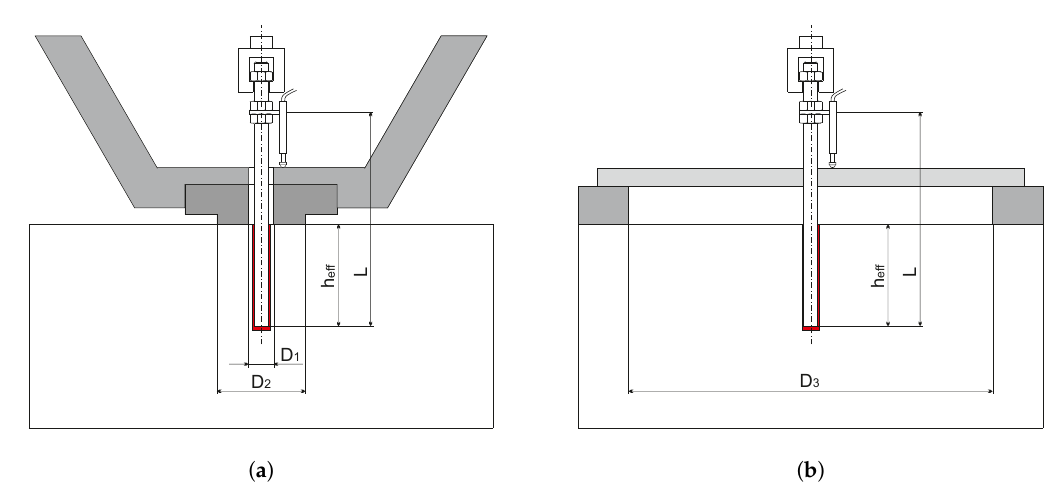
Figure 5. Test set-up of: ( a ) confined pull-out tests and ( b ) unconfined pull-out